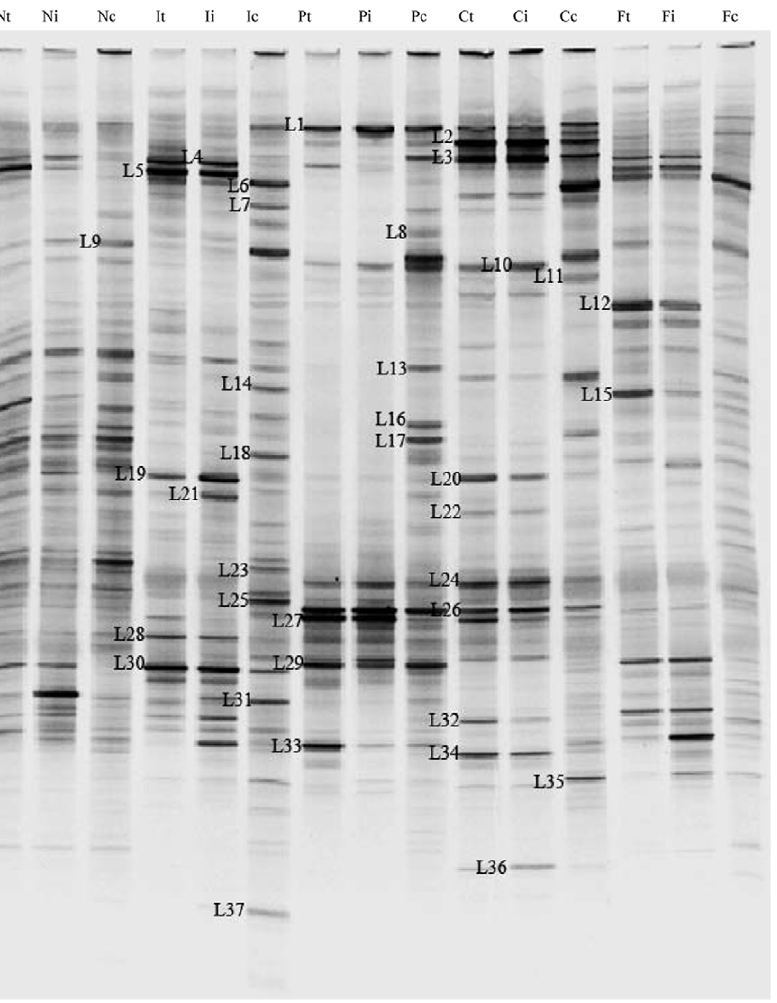
Figure 1. DGGE analysis of the bacterial community in the lumen contents of different treated transplantation rats. Bacterial community profiles were generated from the DNA of luminal samples using the universal PCR primers 8f and 798r. N, normal control group; I, Syn group; P, PBS group; C, CO group; F, FO group. t, transplanted intestine; i, ileum; c, colon.